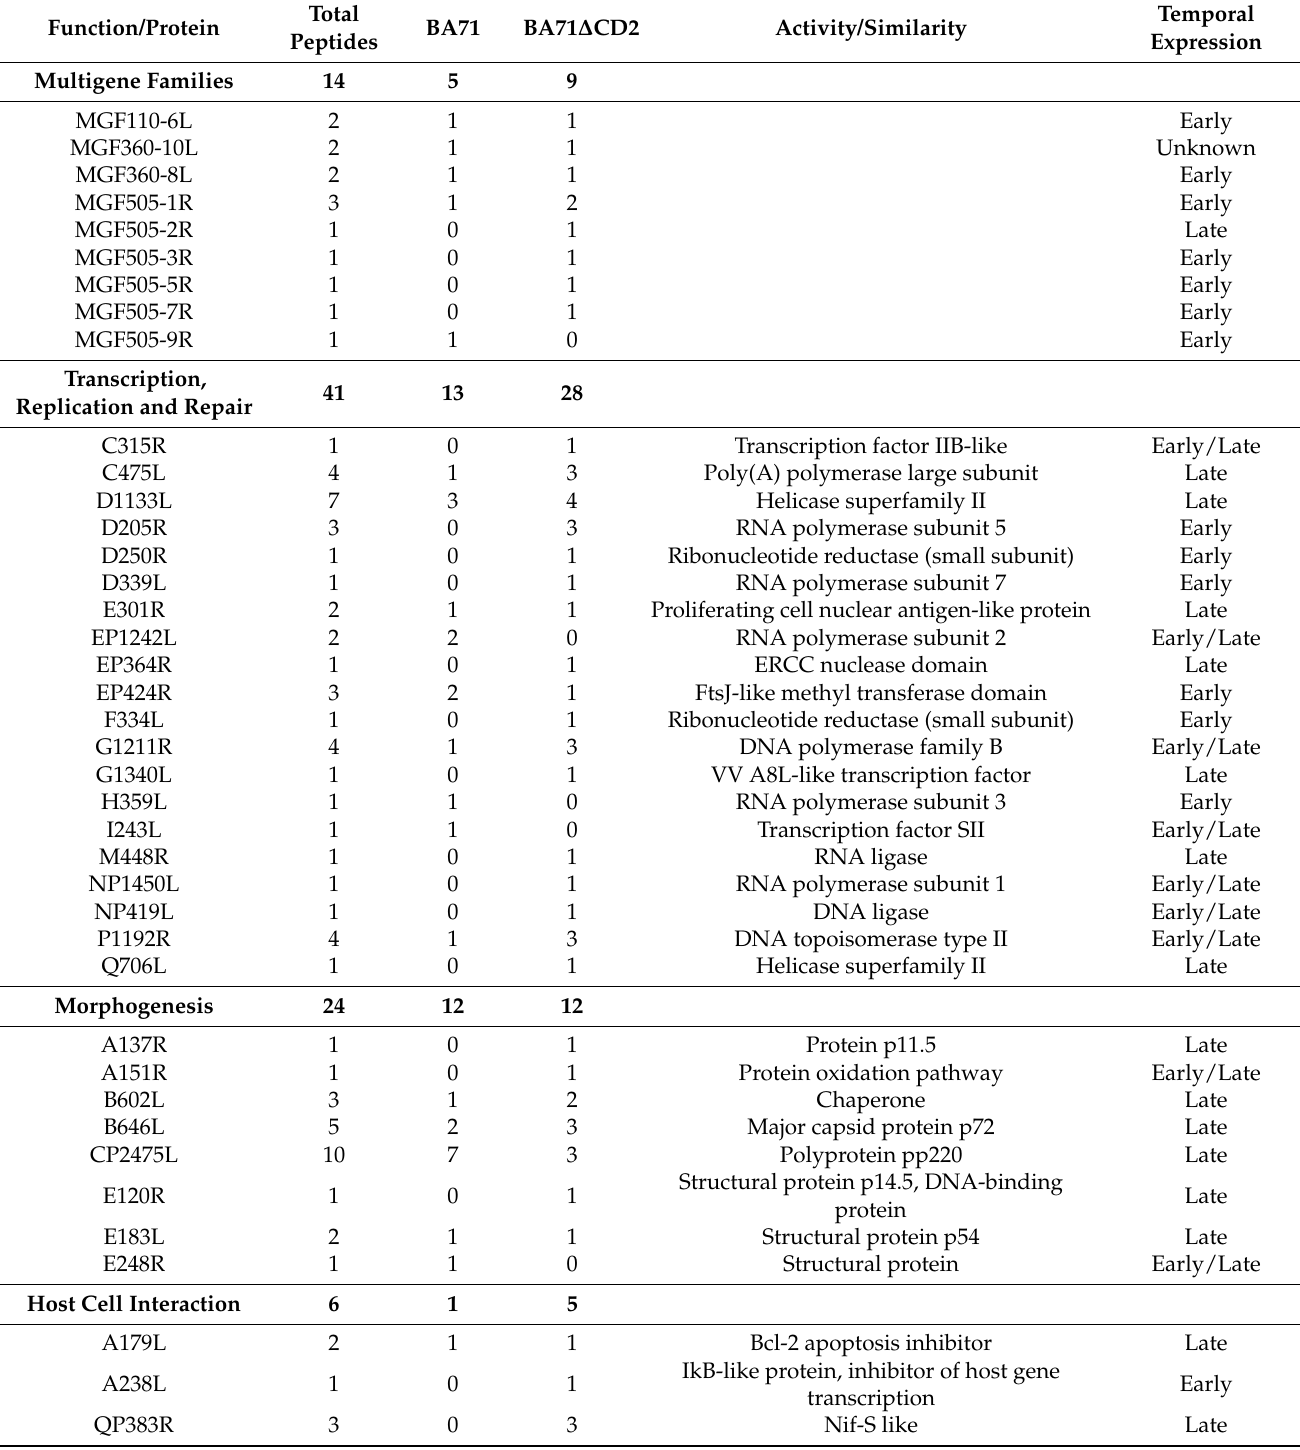
Table 2. Summary of SLA I-restricted ASFV peptides identified by MS-based